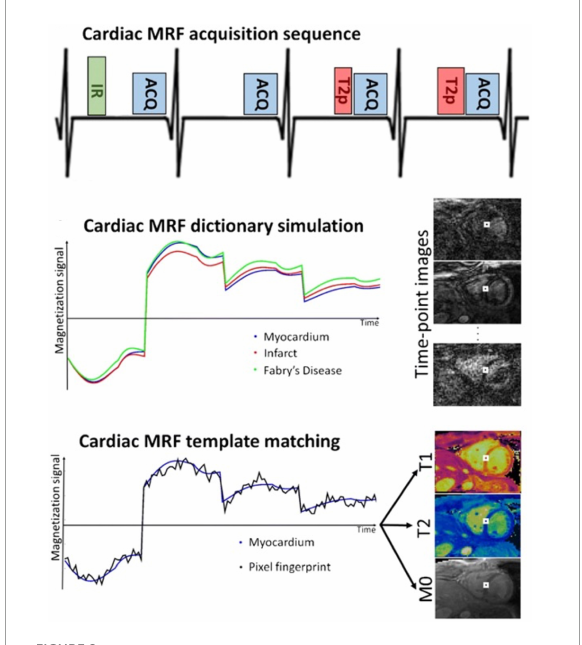
FIGURE8 Example of the Fingerprinting workflow, including the dictionary matching process, and images obtained using the cardiac Fingerprinting sequence. This sequence simultaneously quantifies T1 and T2 in the myocardium. The figure shows acquisition of only 4-heartbeats of the 16-heartbeat acquisition method. In each heartbeat an inversion recovery (IR), T2 preparation (T2p), or no preparation pulse is used before the data acquisition (ACQ). Image taken from Cruz et al.